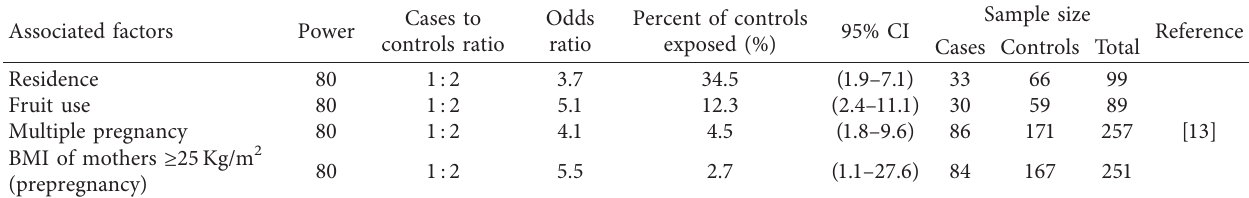
Table 1: Factor analysis to determine sample size using different associated factors of pregnancy-induced hypertension.